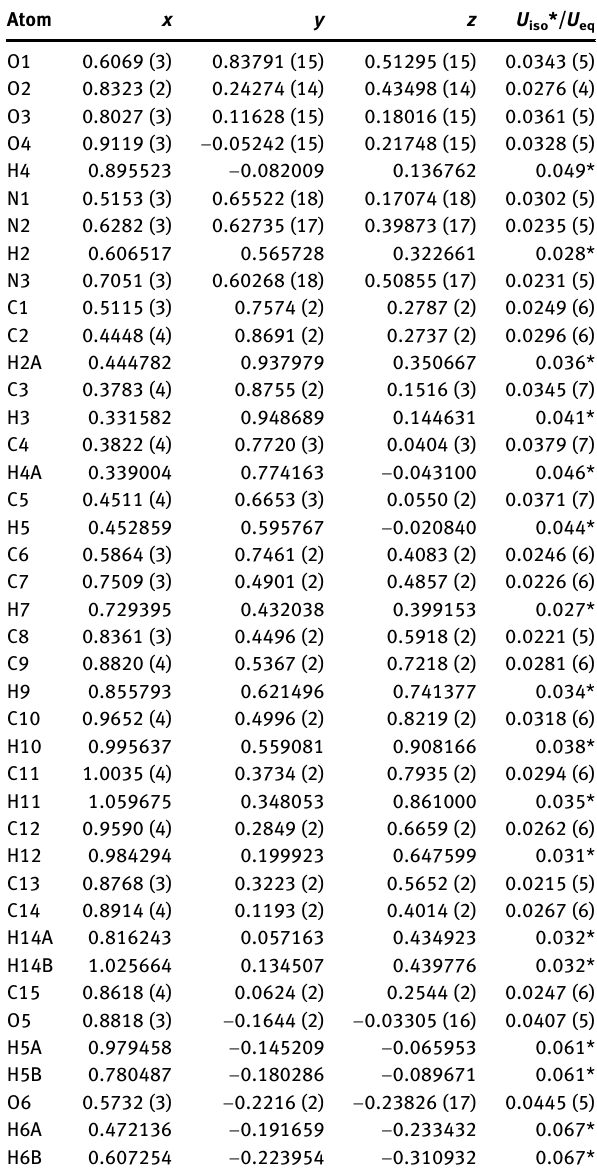
whole hydrazone molecule is almost coplanar. In the crystal packing, the chain structure was formed by intermolecular O-H ⋯ O hydrogen bonds.